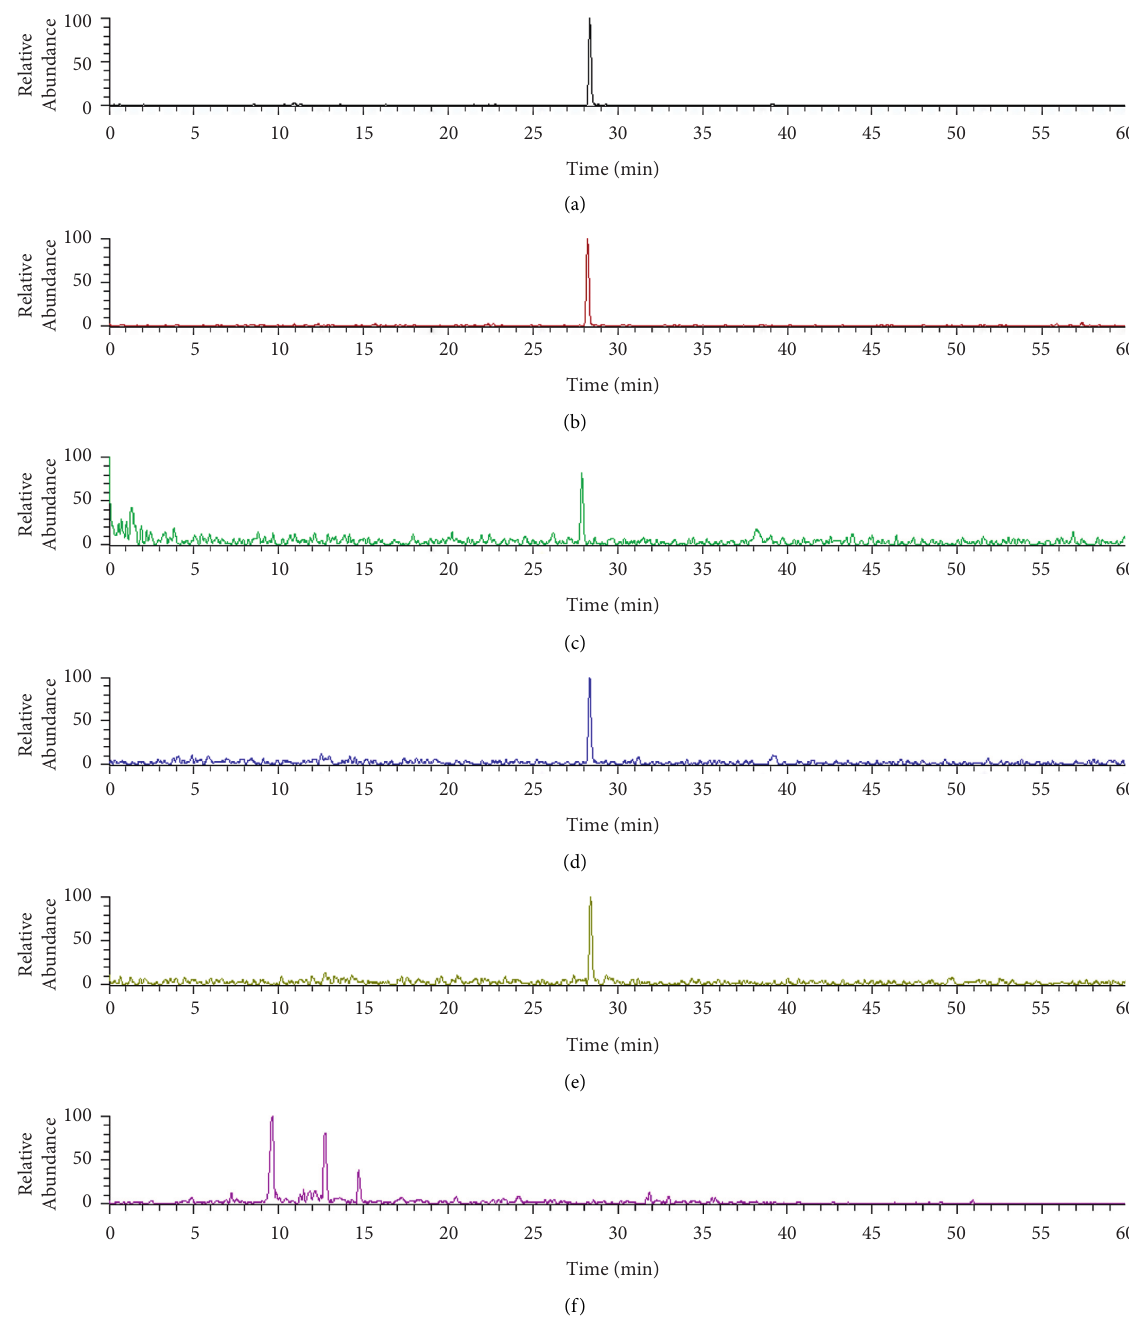
Figure 7: SIM of 246 in (a) Senecio nemorensis, (b) Senecio vulgaris, (c) Senecio cannabifolius, (d) Senecio cannabifolius var. integrifolius, (e) Senecio scandens, and (f) Ligularia